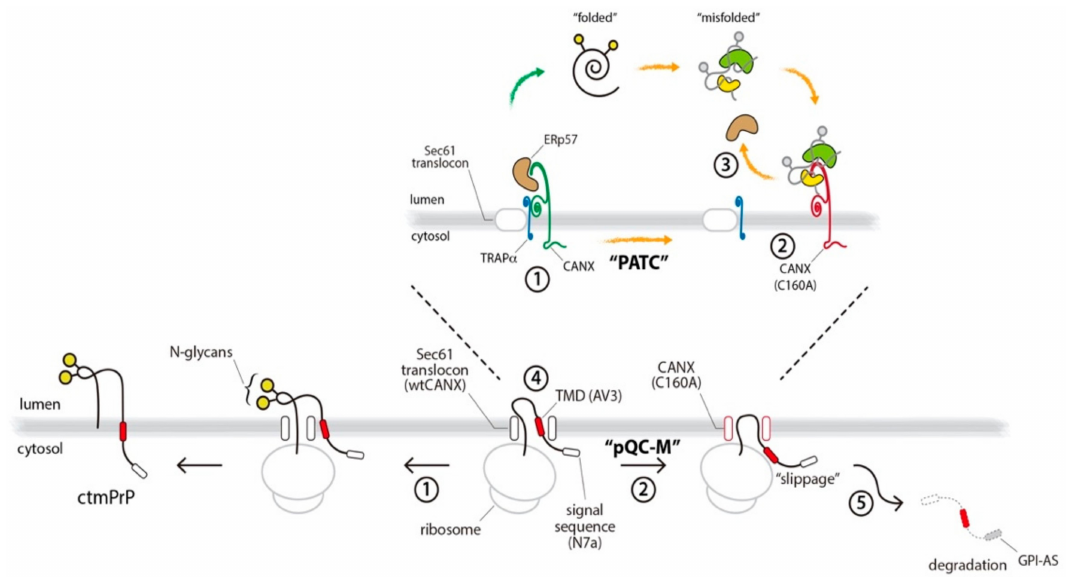
Figure 6. Working model depicting the functional link between PATC and pQC-M. Redox-sensitive selective inhibition of ctmPrP synthesis through translocational regulation is